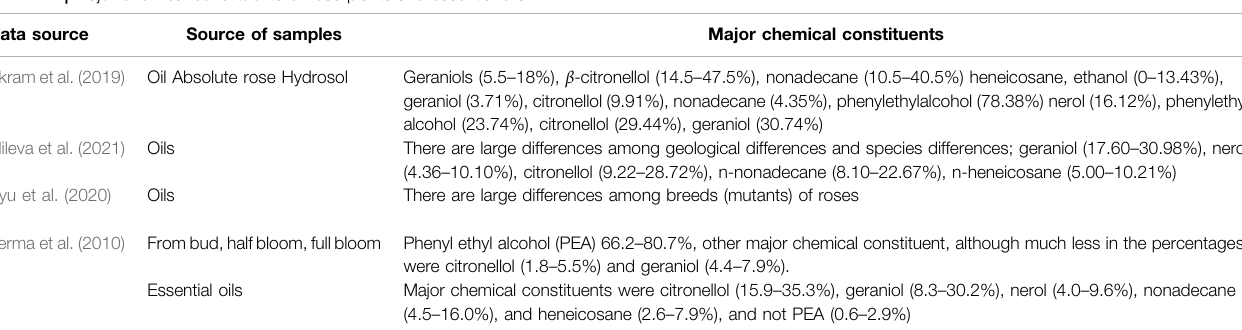
TABLE 4 | Major chemical constituents of rose plants and essential